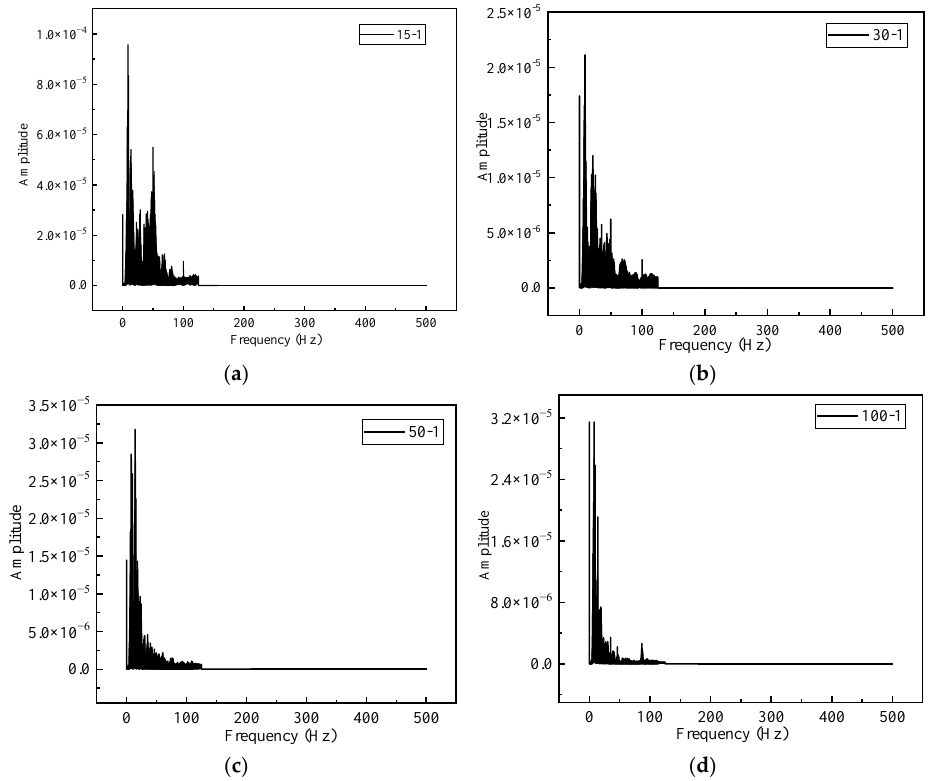
Figure 5. Fourier spectrum curves of acceleration in the vertical direction: ( a ) 15-1; ( b ) 30-1; ( c ) 50-1; ( d ) 100-1.